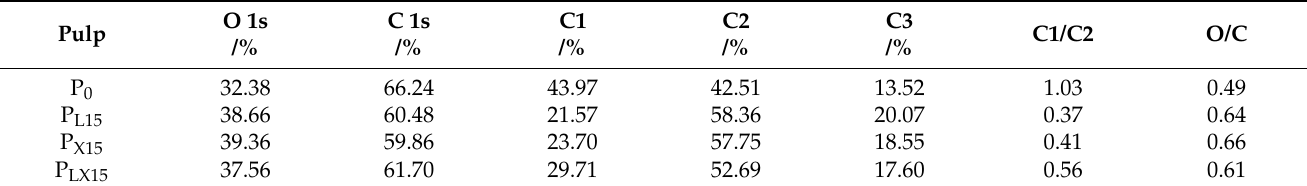
Table 2. Pulp surface